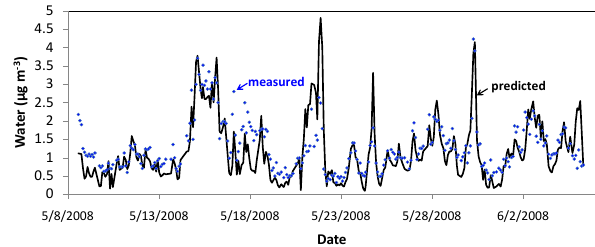
Fig. 9. Particulate water as measured by the AMS (blue points) versus predicted water (black line). The RH used for the model is the indoor RH (RH of the aerosol sample at room temperature) at which the AMS measurements were